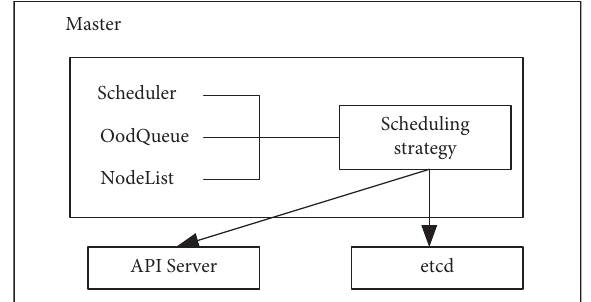
Figure 1: Schematic diagram of Kubernetes scheduler.